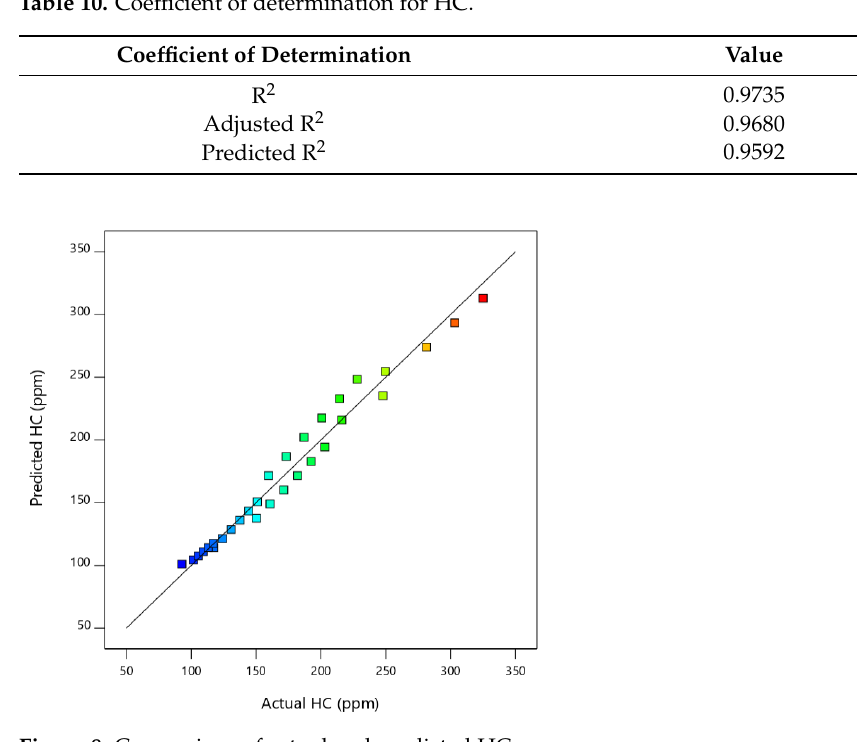
(6) Table 11. ANOVA results for noise. Source